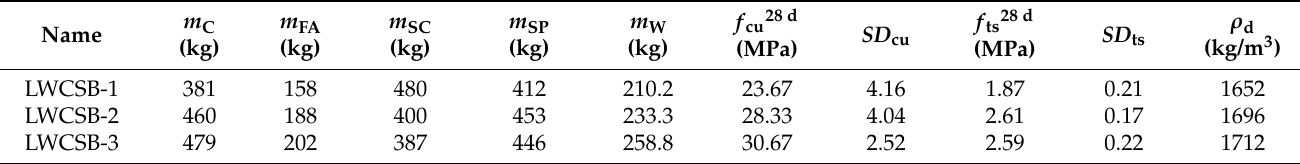
Table 2. The mixes (1 m 3 ) and strengths of ALWSCC [2].